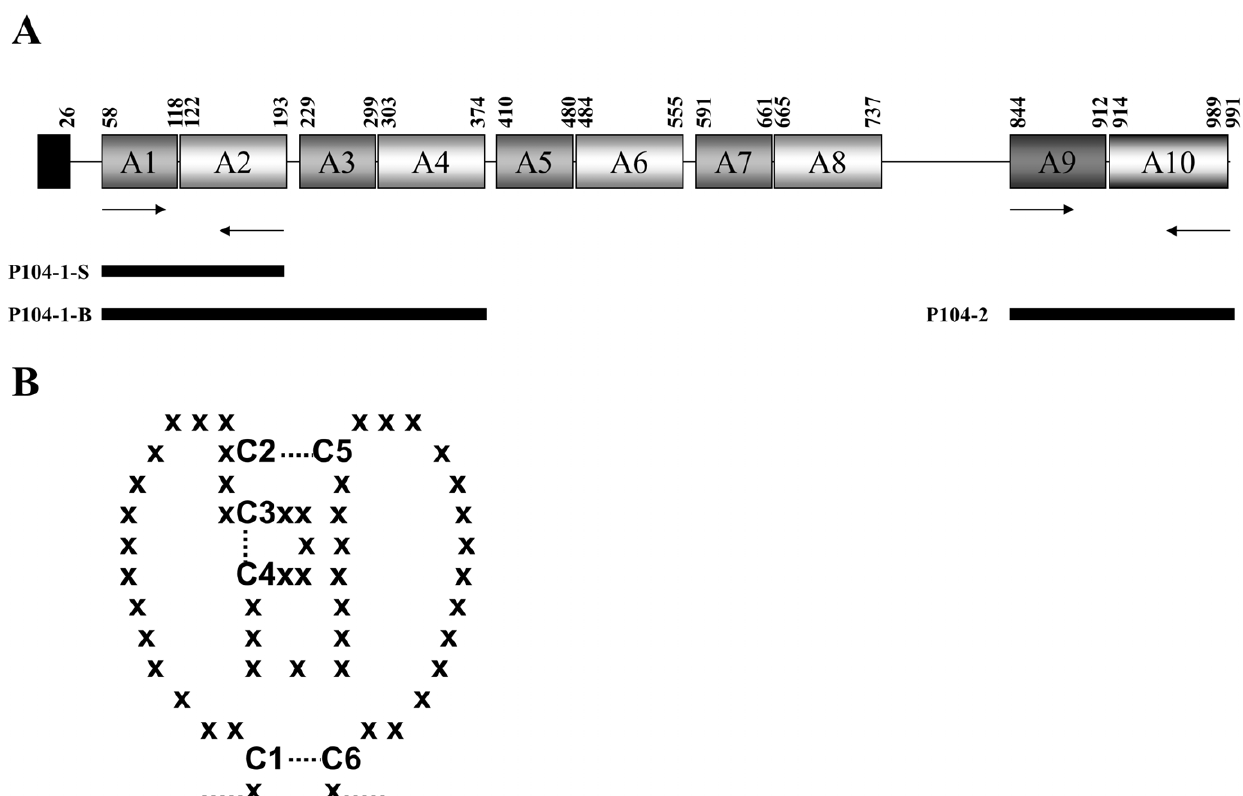
Figure 1. Analysis of the P104 protein sequence. A. The signal peptide is indicated by black rectangle. A1, A3, A5, and A7 are indicated by a dark gray rectangle. A2, A4, A6, and A8 are indicated by a light gray rectangle. A9 and A10 are shown in light black and shiny black rectangles. The arrows at the N- and C-termini indicate the designated primers; the corresponding PCR products are indicated by black bands. B. The putative apple- like structure of a PAN/apple domain. C1–C6 (shown in bold) indicate the six cysteine residues that form three disulfide bridges.